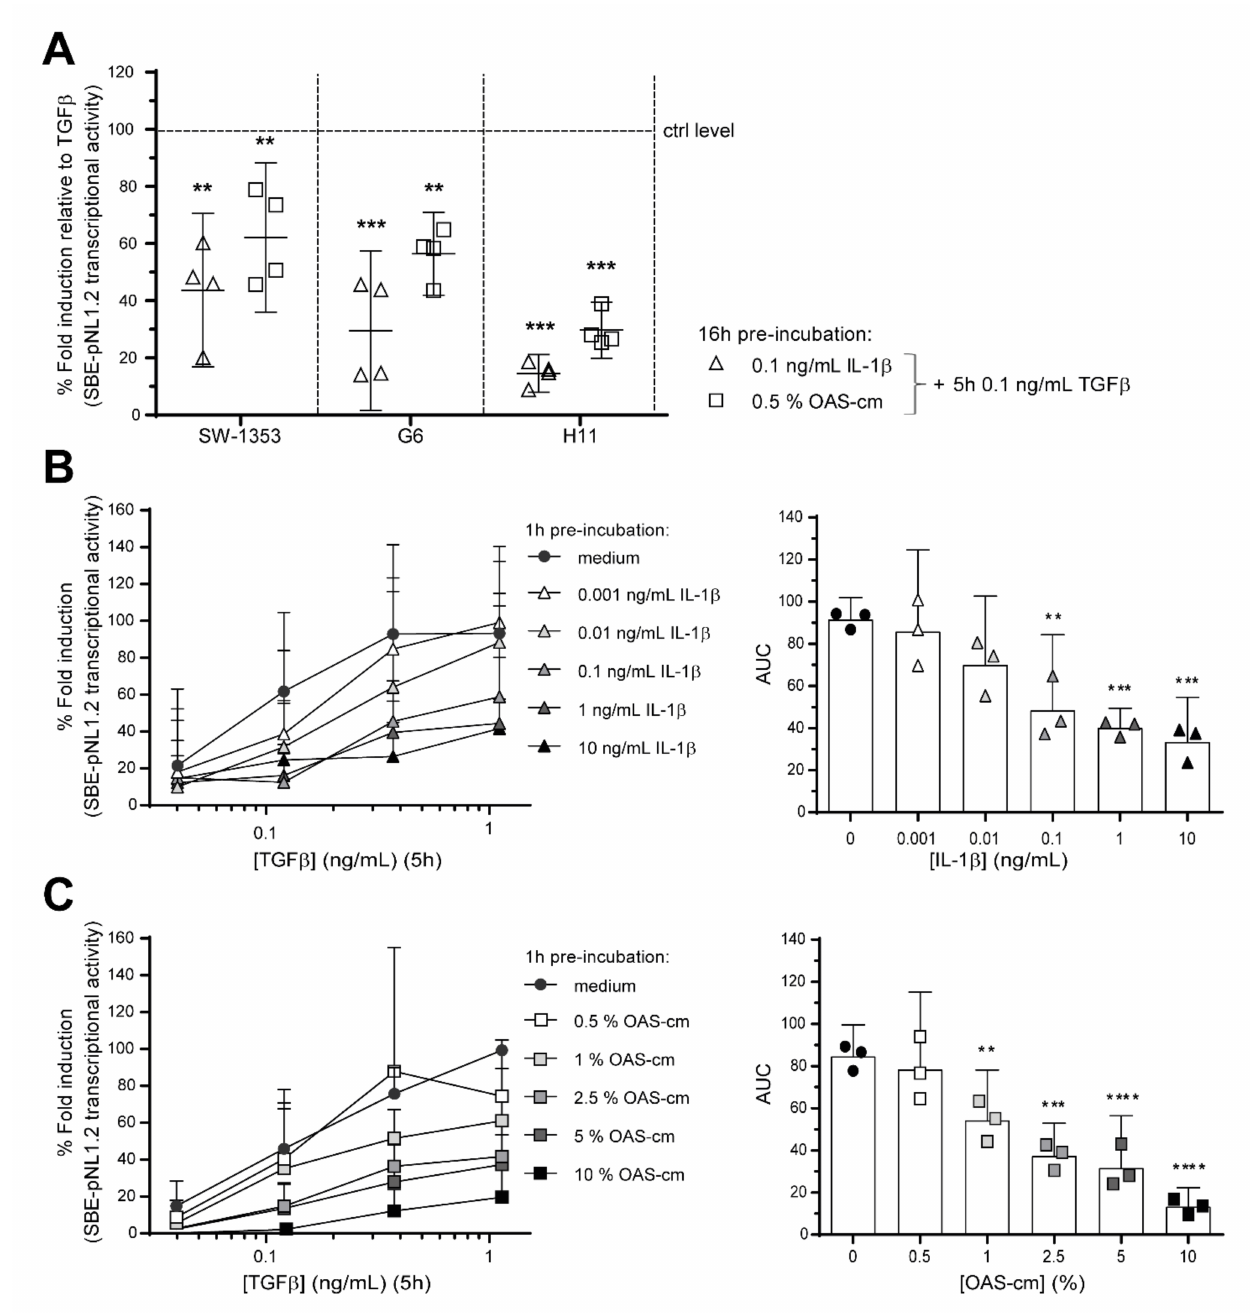
Figure 2. OA-related inflammation inhibits TGF- β transcriptional activity in particular chondrocytes. To study interaction between OA-related inflammation and functional TGF- β signaling, three chondrocyte-like cell lines (SW1353, G6 and H11) were transfected with a SMAD2/3 transcriptional reporter construct (SBE-pNL1.2). ( A ) After transfection, cells were re-plated, pre-incubated overnight (16 h) with medium, 0.1 ng/mL IL-1 β or 0.5% OAS-cm and, thereafter, stimulated for 5 h with 0.1 ng/mL TGF- β . Luciferase activity was measured relative to experimental condition stimulated with TGF- β , as set at 100% (ctrl level). Data represent mean ± 95% CI of four independent experiments performed in quadruple. ( B , C ) In SW1353 cells, this was investigated further, but now with 1 h pre-incubation with a concentration series of ( B ) IL-1 β (0.001–10 ng/mL) or ( C ) OAS-cm (0.5–10%) before stimulation with increasing concentrations of TGF- β for 5 h. Data represent mean ± 95% CI of three independent experiments performed in quadruple. Per experiment the area under the curve (AUC) was calculated and displayed. Statistical analysis was performed using a one-way ANOVA with Dunnett’s multiple comparison test comparing the mean to the mean of the condition stimulated with solely TGF- β : ** p ≤ 0.01; *** p ≤ 0.001; **** p <